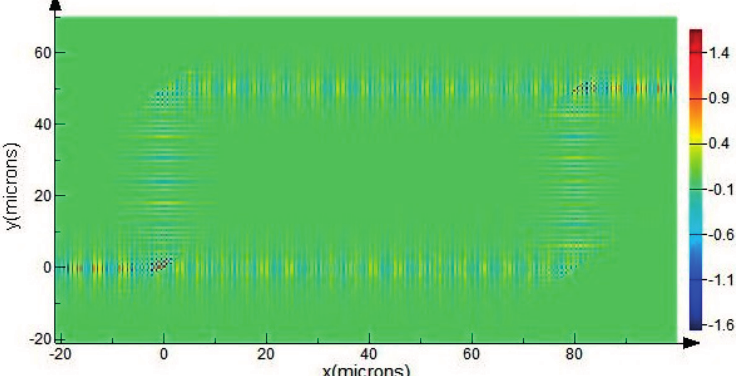
Figure 15. The transmission of the electric field components in Z direction Ez (out of plane) of the MZI structure with EH-polarized mode of SOI rib waveguide with H = 10 μ m, h = 5 μ m, w = 2.5 μ m at wavelength of 1550